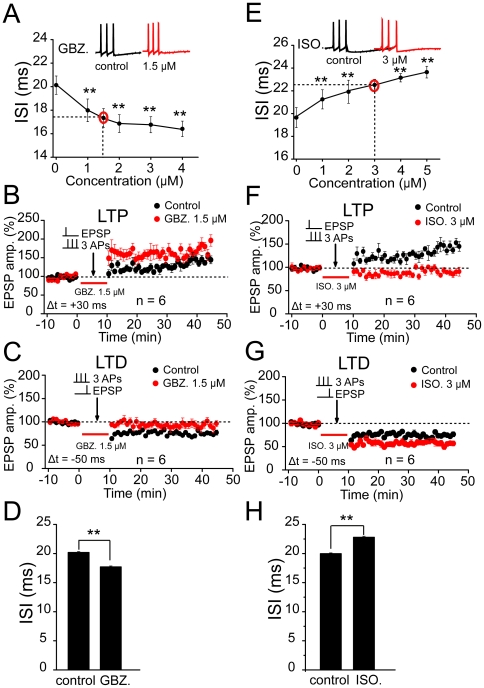
Pharmalogical manipulation of ISI mimicked the regulation of STDP by prior TBS.(A) Dose-response relationship of a selective GABA receptor antagonist Gabazine (GBZ). Sample traces at the top, GBZ at a concentration of 1.5 µM shortened the ISI similarly to the prior EPL stimulation. (B) Application of 1.5 µM GBZ during STDP induction facilitated LTP by increasing the potentiation magnitude (n = 6, p<0.001). (C) Application of 1.5 µM GBZ during STDP induction suppressed LTD by decreasing depression magnitude (n = 6, p<0.05). (D) Statistical plot showing the effect of GBZ (1.5 µM) in shortening the ISI (n = 6, p<0.01). (E) Dose-response relationship of a selective GABA receptor agonist isoguvacine (ISO). Sample traces at the top, ISO at a concentration of 3.0 µM prolonged the ISI similarly to the prior GCL stimulation. (F) Application of 3.0 µM ISO during STDP induction suppressed LTP by decreasing the potentiation magnitude (n = 6, p<0.01). (G) Application of 3.0 µM ISO during STDP induction facilitated LTD by increasing the depression magnitude (n = 6, p<0.001). (H) Statistical plot showing the effects of ISO (3.0 µM) in prolonging the ISI (n = 6, p<0.01). The control in B and F were same as those in Fig. 3C, and the control in C and G were obtained from Fig. 3G.